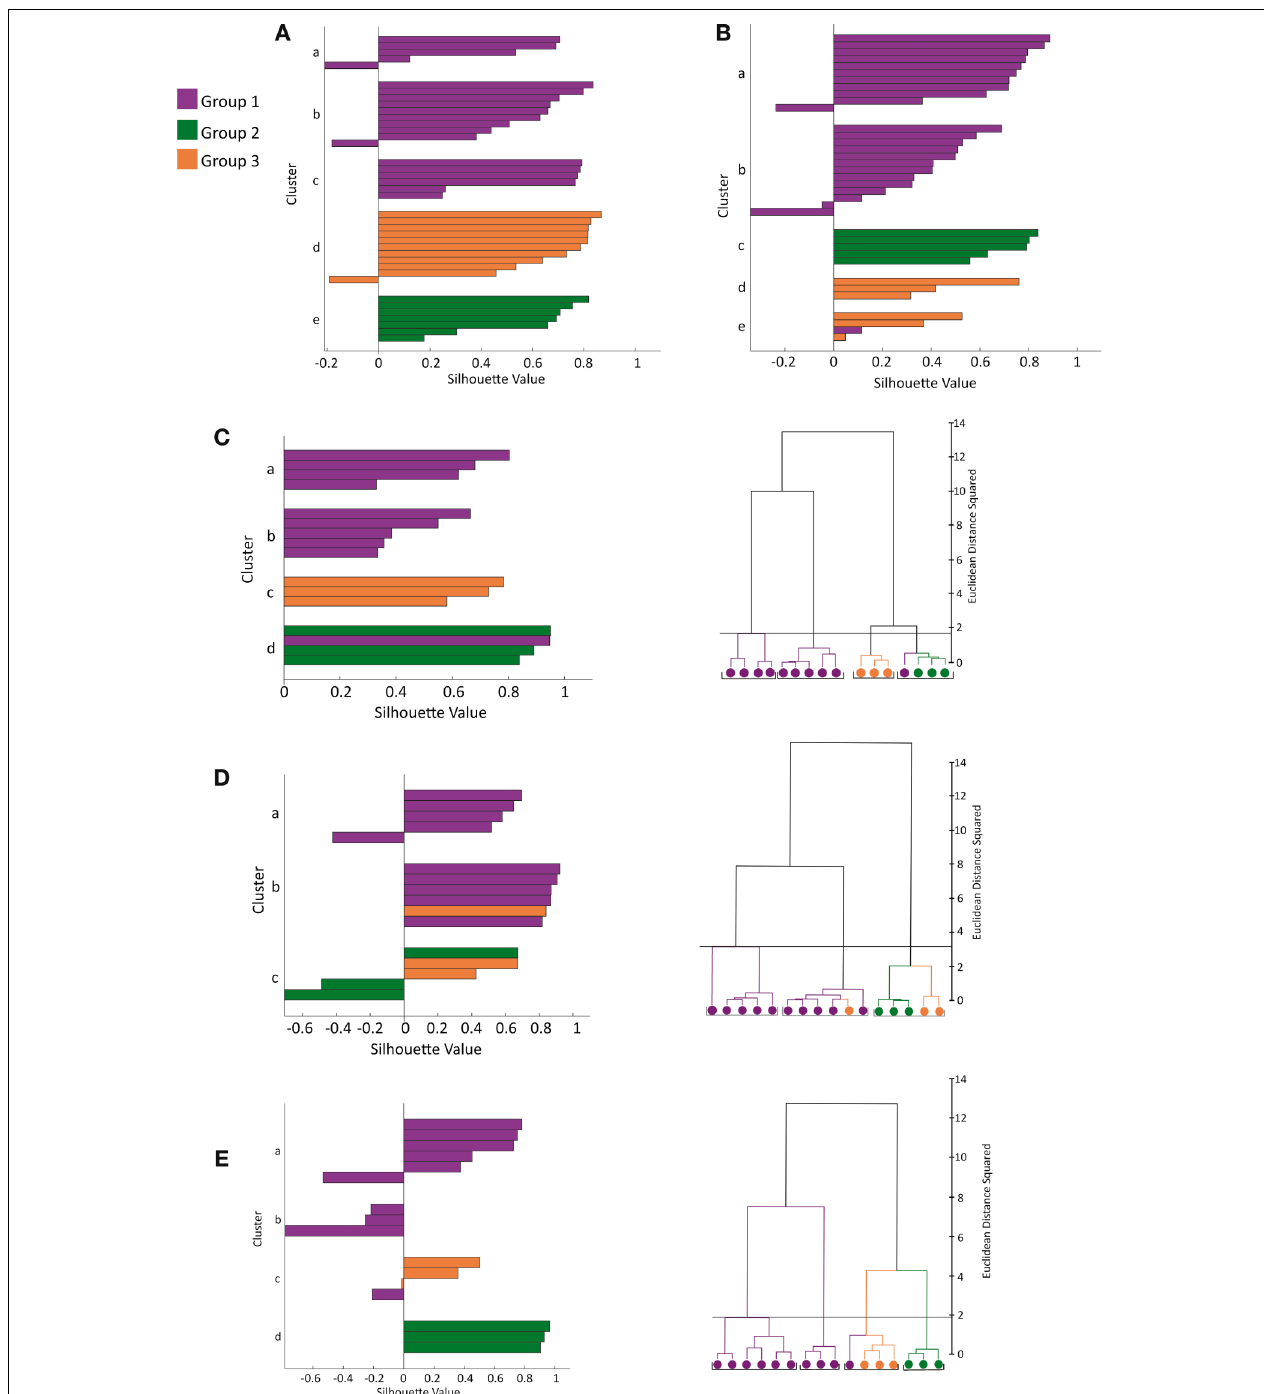
dendrogram of this dataset). (C–E) Plot of silhouette values (left) and dendrogram (right) for clustering of the 16 cells with both recordings and reconstructions by morphological variables (C) , by electrophysiological variables (D) and by electrophysiological and morphological variables (E) . The fi rst 2 principal components were retained for cluster analysis by the morphology variables (C) and electrophysiological variables (D) . The fi rst 3 principal components were retained for cluster analysis by both the electrophysiology and morphology variables (E) . Again the color scheme is based on the clustering by morphology (see Figure 1